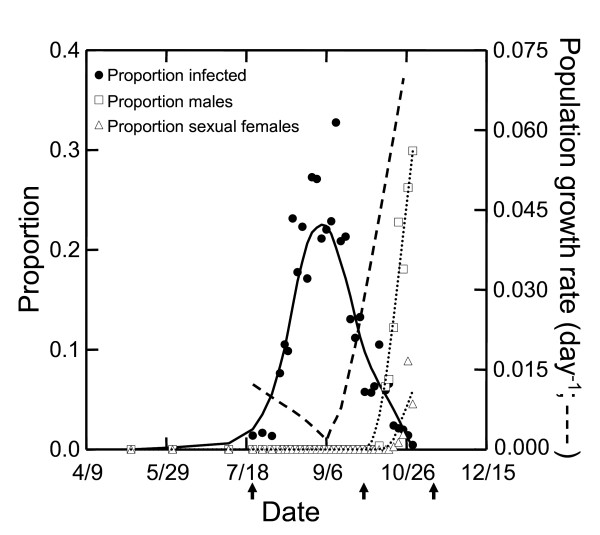
Daphnia dentifera population dynamics and infection prevalence. Left axis: proportion of D. dentifera population infected with Metschnikowia (circles); proportion of population that are males (squares); proportion of population that are sexual females (open triangles). Right axis: instantaneous population growth rate (r; dashed line). Arrows indicate dates on which clones were collected for assays: first arrow: pre-epidemic, second arrow: post-epidemic, third arrow: post-sex sampling. Locally weighted (lowess) smoothing lines are shown.